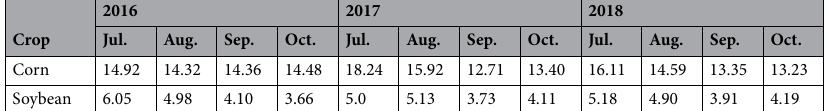
Table 7. The MAE of the corn and soybean yield prediction performances of our proposed model. The unit of MAE is bushels per acre.